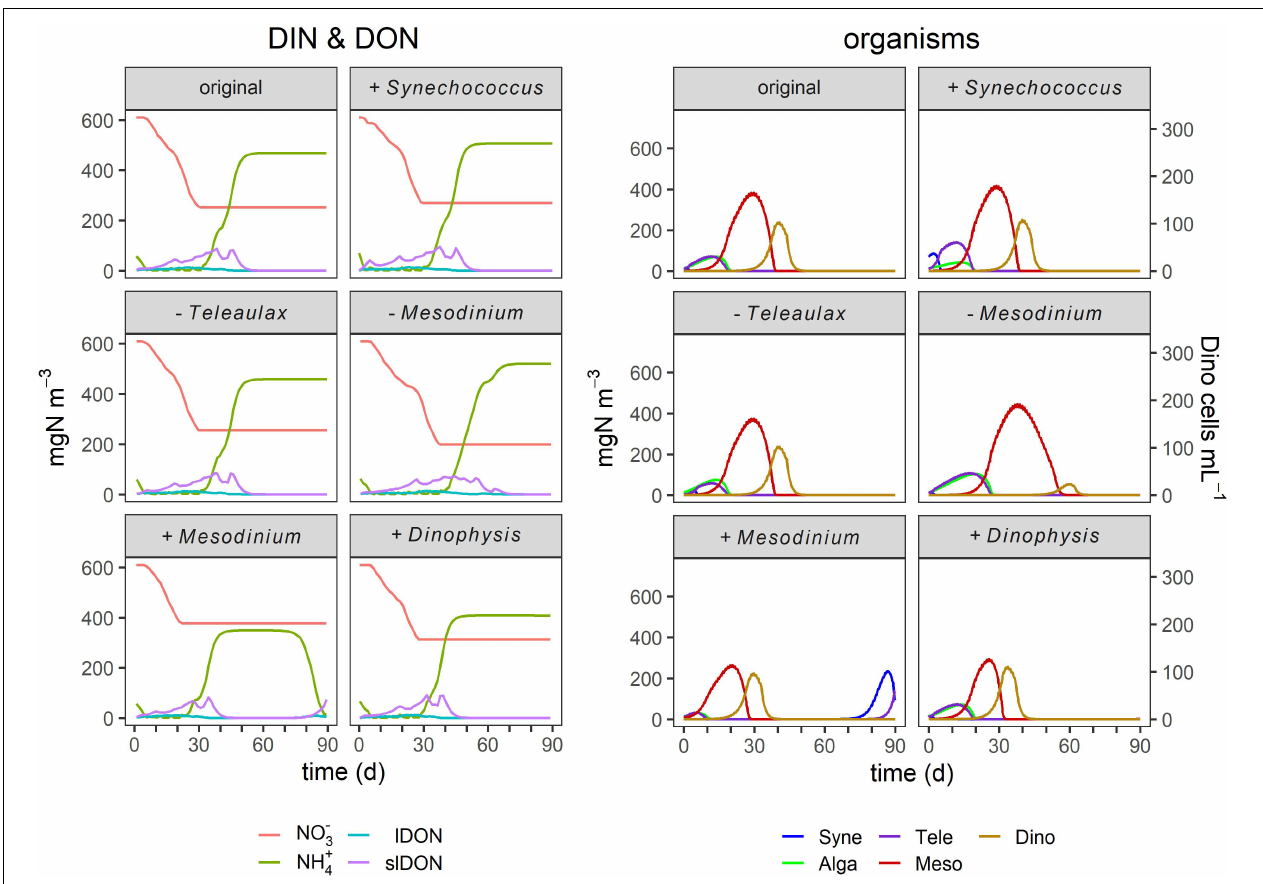
FIGURE 5 | Effect of initial organism ratios on TMD dynamics. These simulations were conducted as for Figure 4 , with different nutrient loads, but now with higher (“+”) or lower (“ − ”) inocula. The panels labeled “original” are replicated from Figure 4 , as default (control). The complete list of conditions and details of the simulations are listed in Table 4 and described in the legend of Figure 4